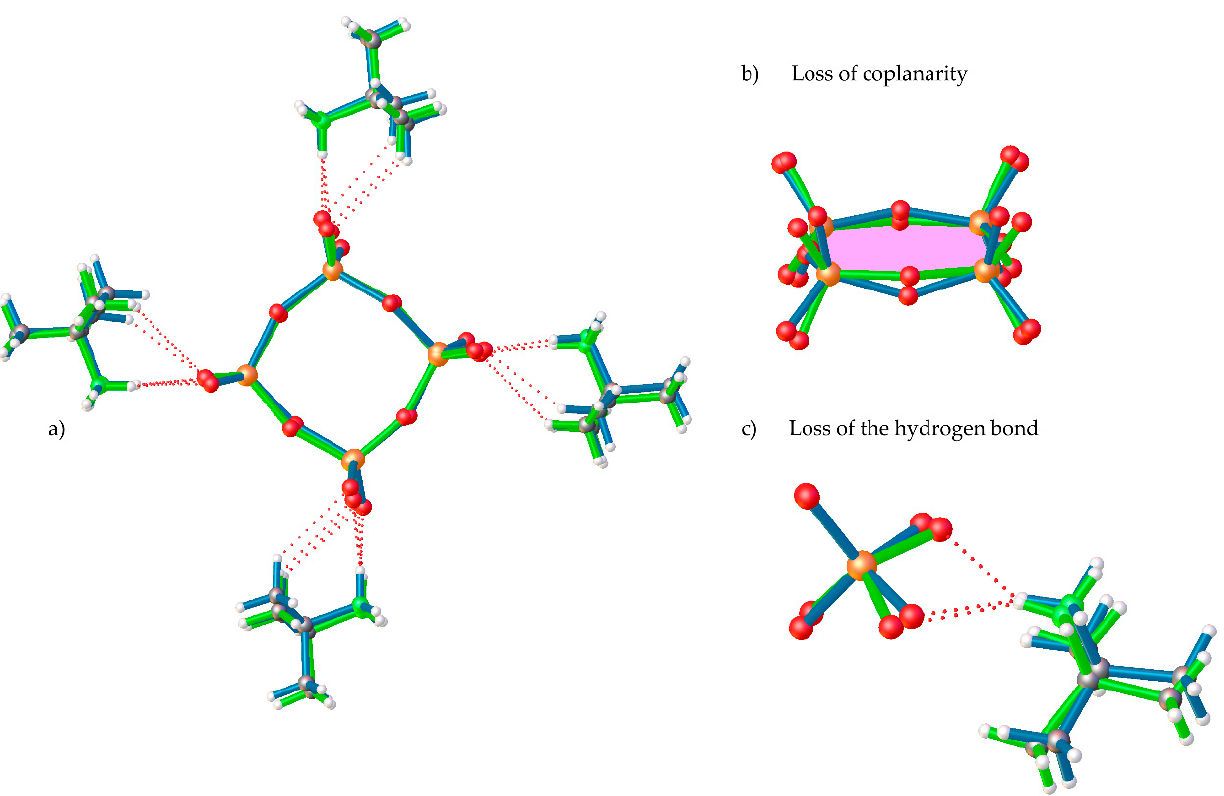
with two of the bridging oxygen atoms are still coplanar, whereas the two remaining ring oxygen atoms, O34 and O12, are located 0.23 and 0.47 Å away from the plane, respec- tively. This displacement of the ring implies changes in the hydrogen bonds between tert -butylammonium anions and the terminal oxygens, with the loss of a NH ··· O bond and the consequent rearrangement of the crystal packing. The distances and angles of the V-O bonds are shown in Table S1 in the Supplementary Materials.